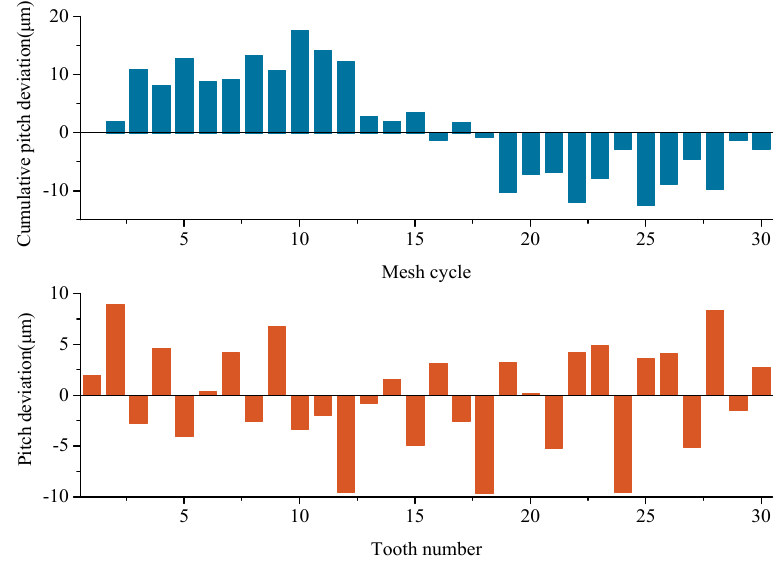
Figure 8. Definition of random cumulative pitch deviations and pitch deviations.